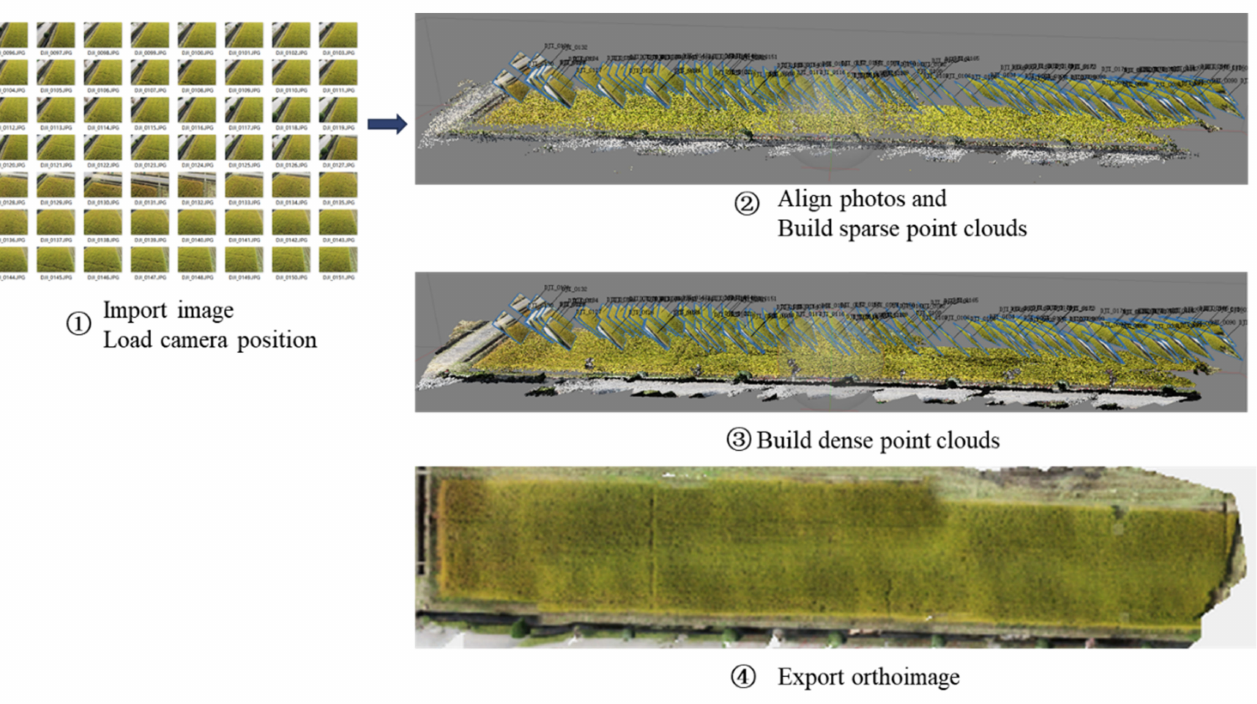
Figure 2. Generating mature rice orthoimage. Agisoft Photoscan processing workflow and export for orthomosaic; four-step semi-automated processing